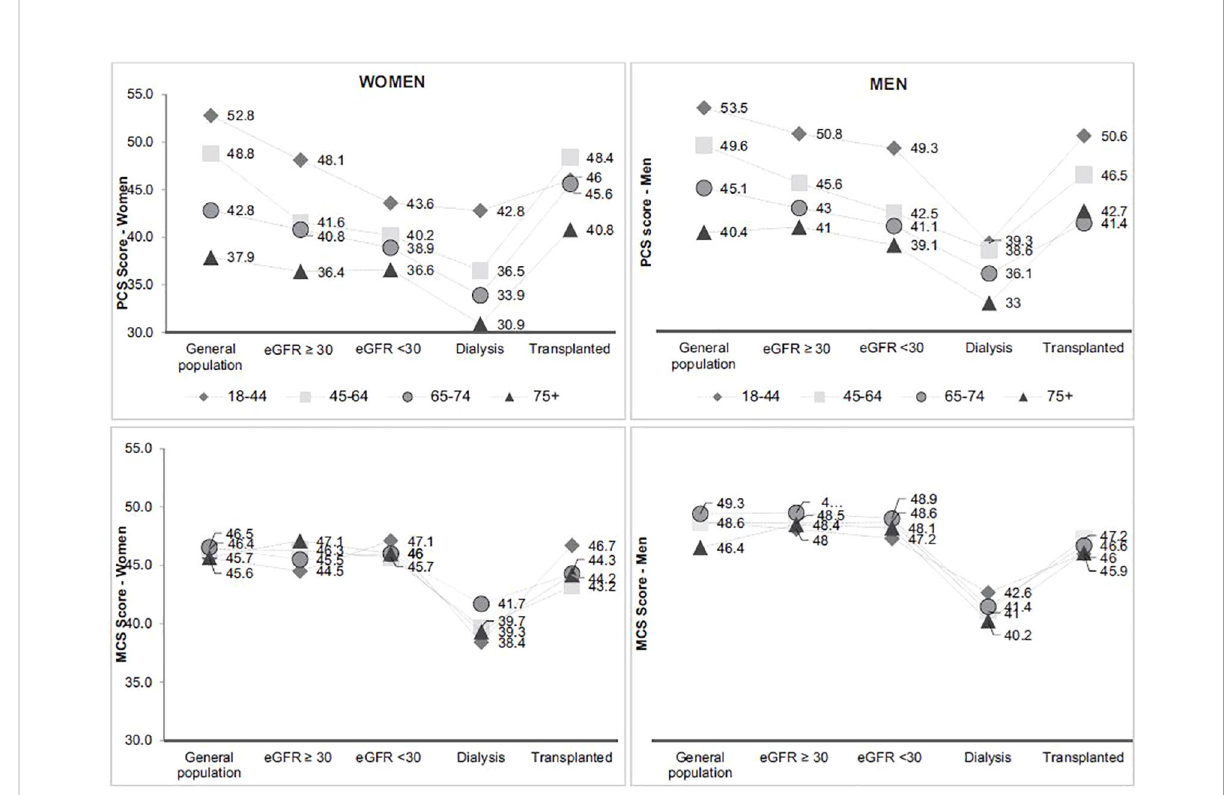
FIGURE 7 Physical and mental health score according to age and CKD status* (source CKD-REIN, REIN registry). Adapted from Legrand et al., 2020 (57). MCS Mental Component Summary, PCS Physical component Summary. *Gray lines connect the symbols for each age group to facilitate visualization of each group between kidney disease status groups. They do not re fl ect the course of health-related quality of life across